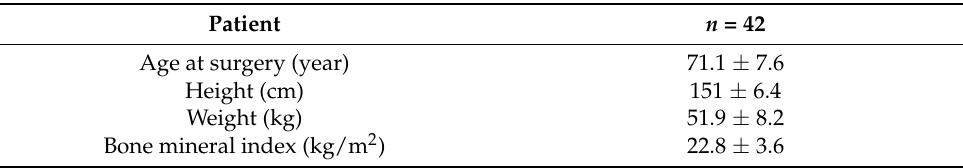
Table 1. Patient